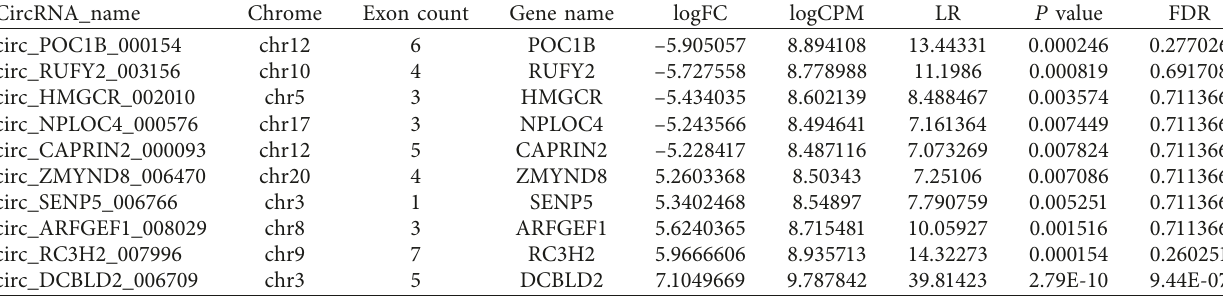
Table 3: The most significant differentially expressed circular RNAs (circRNAs) (top 10